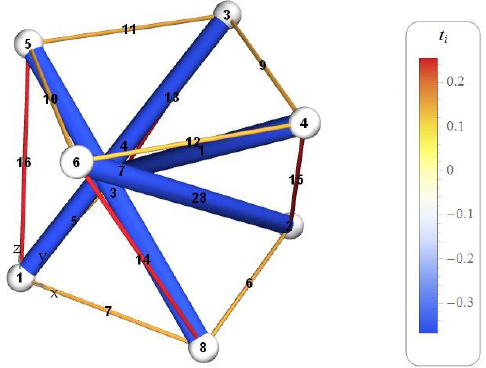
Figure 1: Quadruplex, perspective view. Thick cylinders represent the struts. Different colours have been assigned according to the value of the internal forces in the elements, which are labelled according to the connectivity matrix